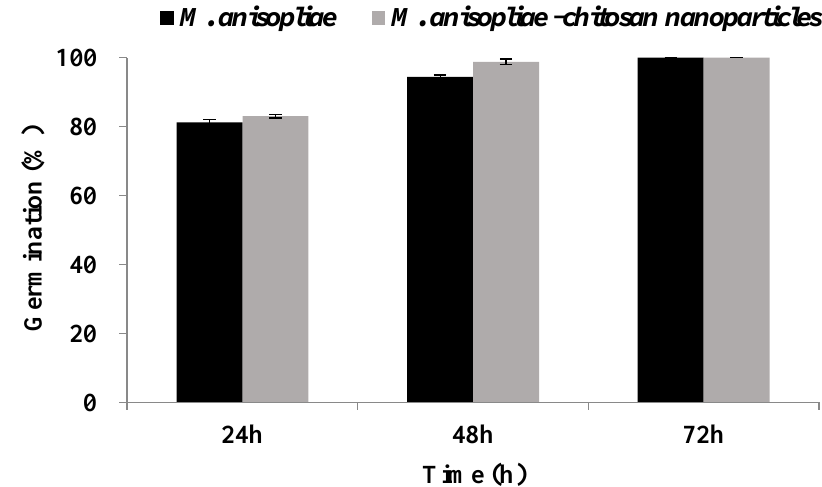
Figure 3. Germination percentage of Metarhizium anisopliae – chitosan nanoparticles and M. anisopliae conidia at different time periods. Error bars indicate the standard error of the means based on three replicates.